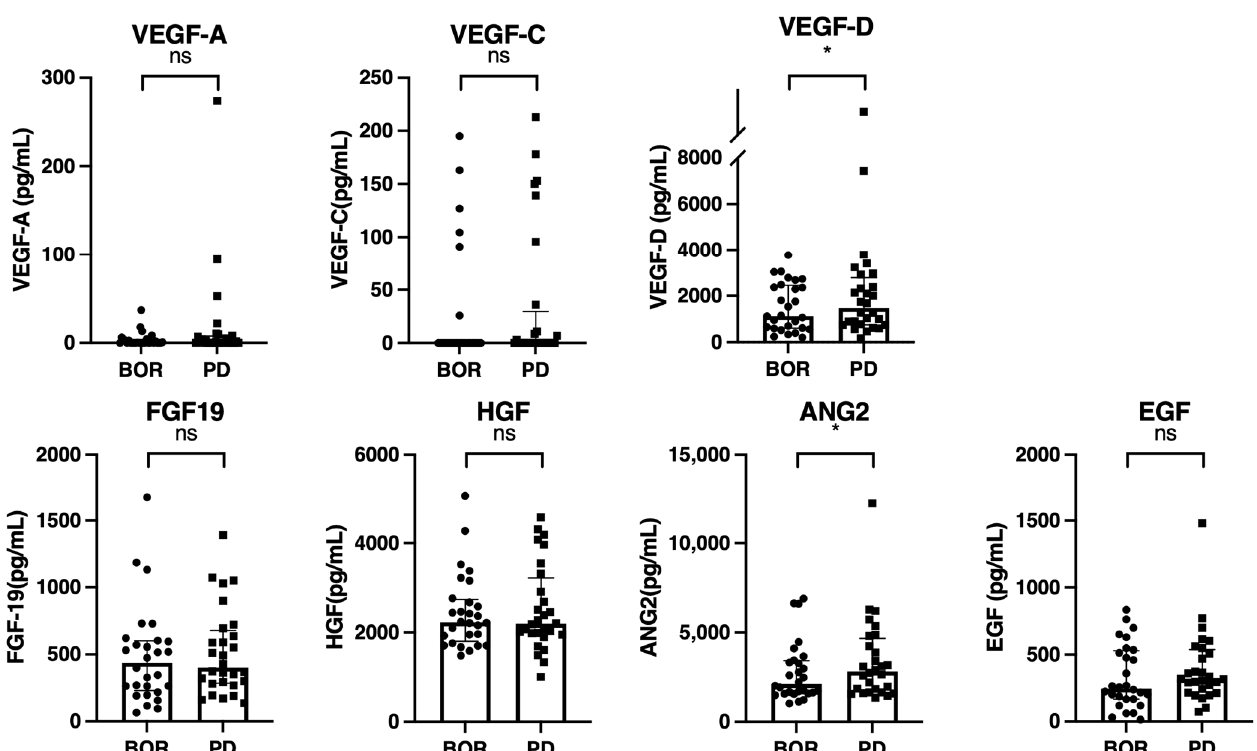
Figure 5. Changes in growth factors between the best overall response points and progressive disease points ( n = 28). Serum median VEGF-A, VEGF-C, VEGF-D, FGF-19, HGF, ANG-2, and EGF levels were compared between the best overall response and PD points in 28 patients who experienced PD after an initial first response to atezolizumab plus bevacizumab. The bar graph shows the median serum growth factor levels with an interquartile range indicating the error bars. Asterisks indicate statistically significant differences (* p < 0.05,). ns, not significant. VEGF, vascular endothelial growth factor; FGF-19, fibroblast growth factor-19; HGF, hepatocyte growth factor; ANG-2, angiopoietin-2; EGF, epidermal growth factor; DC, disease control; PD, progressive disease. Table 3. Baseline characteristics of patients who experienced PD after CR, PR, or SD with atezoli- zumab plus bevacizumab.